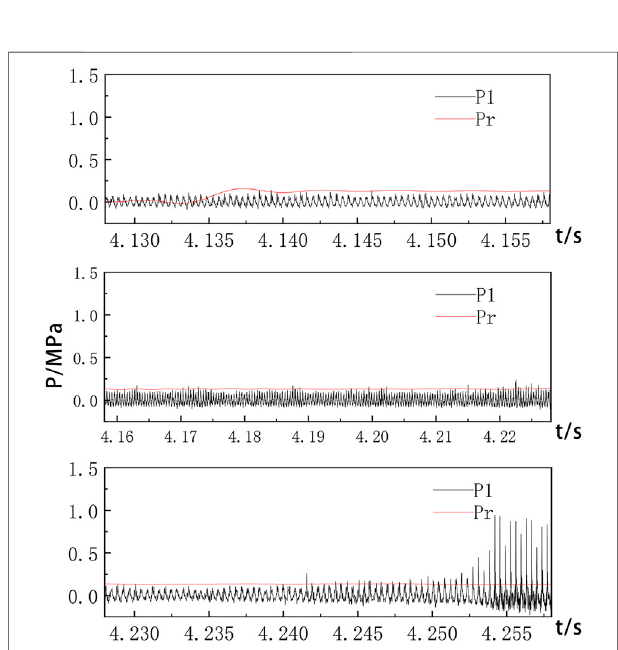
FIGURE 6 | Local segmentation of the pressure signals in the